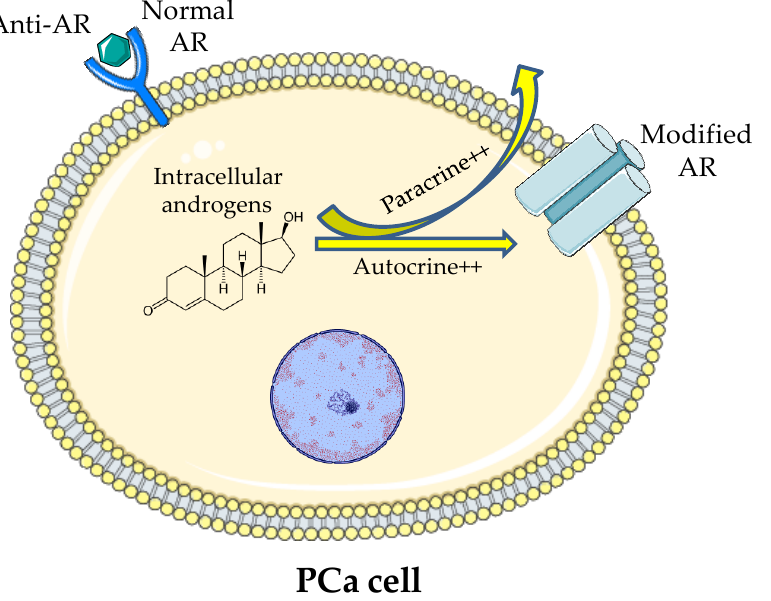
Figure 1. Illustration of the theory of intracellular production of androgen and stimulation of modified ARs occurring despite the low serum testosterone and the blockage of normal ARs.